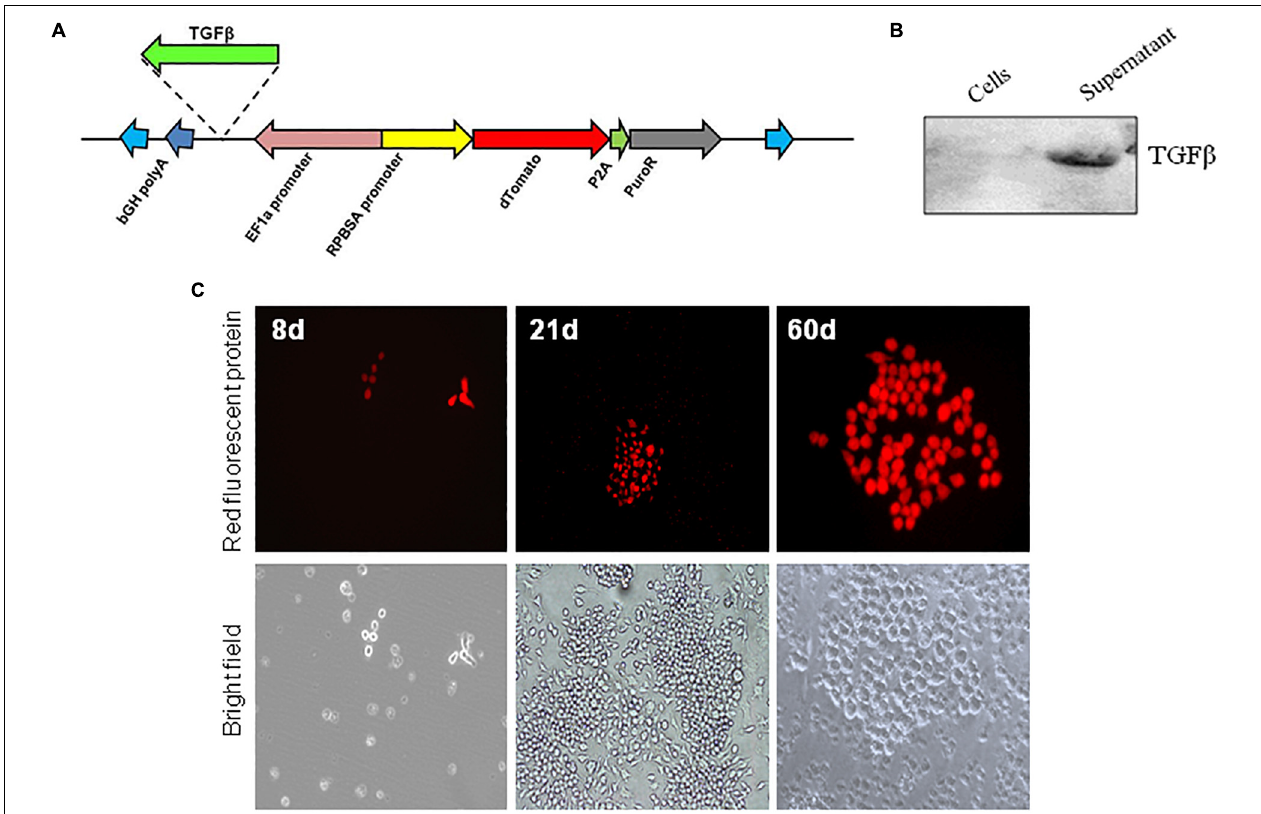
FIGURE 1 | In vitro expression of Sleeping Beauty transposon in RAW 264.7 macrophages. (A) Plasmid (pSBbi-RP-TGF β ) construct for transposon coding for Td-Tomato and a puromycin resistance gene. The location for insertion of the mouse TGF β on the plasmid is shown. In vitro infection of RAW 264.7 macrophages with Salmonella -carrying both the Sleeping Beauty Transposon plasmid pSBbi-RP or pSBbi-RP-TGF β and transposase plasmid pCMV (CAT) T7 SB-100. (B) Western blot of cell lysate and supernatant performed 60 days after bacterial infection of macrophages using a DDK tag for TGF β . (C) Expression of red fluorescent protein at 8, 21, and 60 days post-infection. Fluorescent images were acquired on a ZEISS inverted LSM700 microscope at